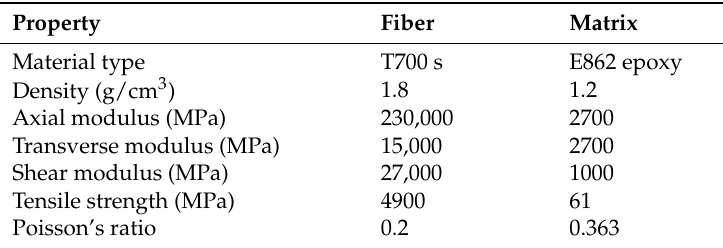
Table 1. Properties of composite